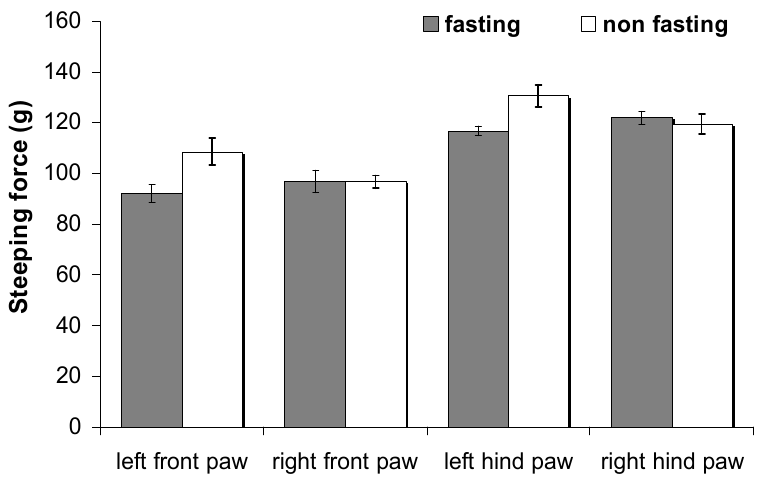
Figure 3. Comparison of stepping forces of the left and right, front and hind paws of fasting and non-fasting rats.